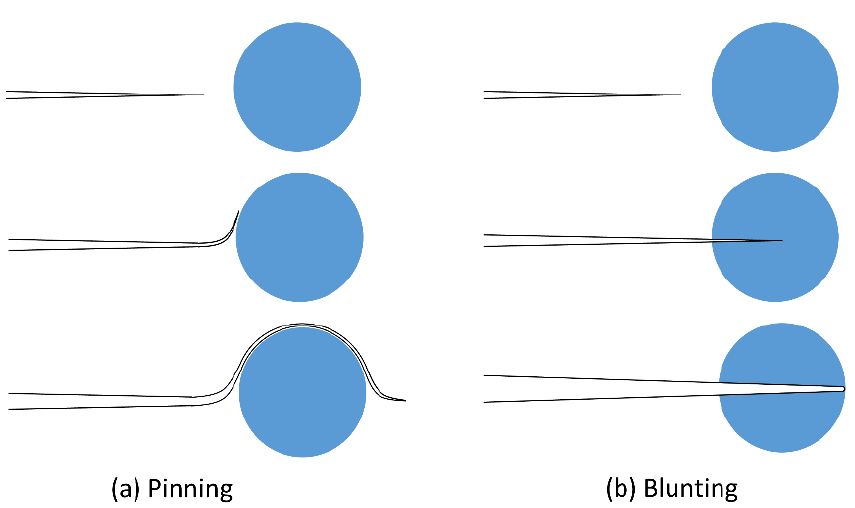
Figure 18. Schematic illustration of successive positions of crack front upon interaction with a second-phase particle, expected for ( a ) glasses consisting of PbO-rich particles/B 2 O 3 -rich matrix, and ( b ) glasses consisting of B 2 O 3 -rich particles/PbO-rich matrix. Recreated from